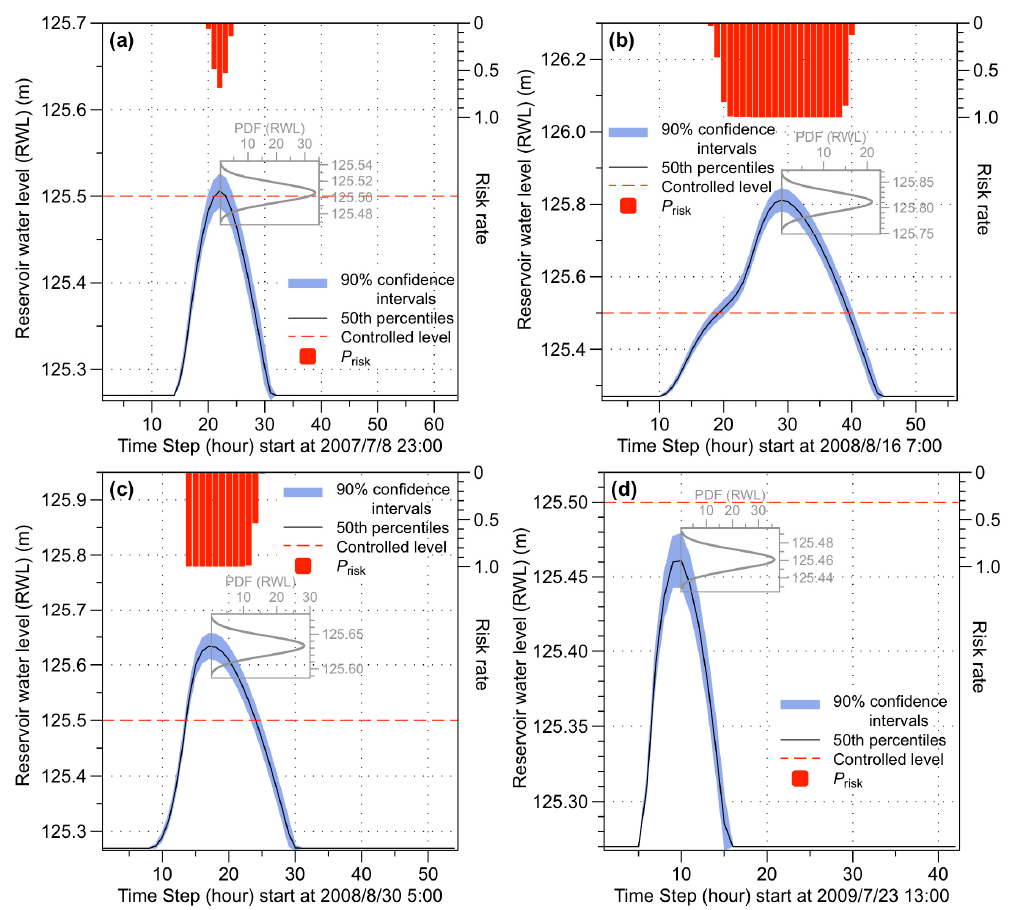
Figure 6. Risk rate calculation of selected flood events for the Meishan Reservoir. The grey small graph is the probability density function (PDF) of reservoir water level (RWL) at the peak occurrence time step.